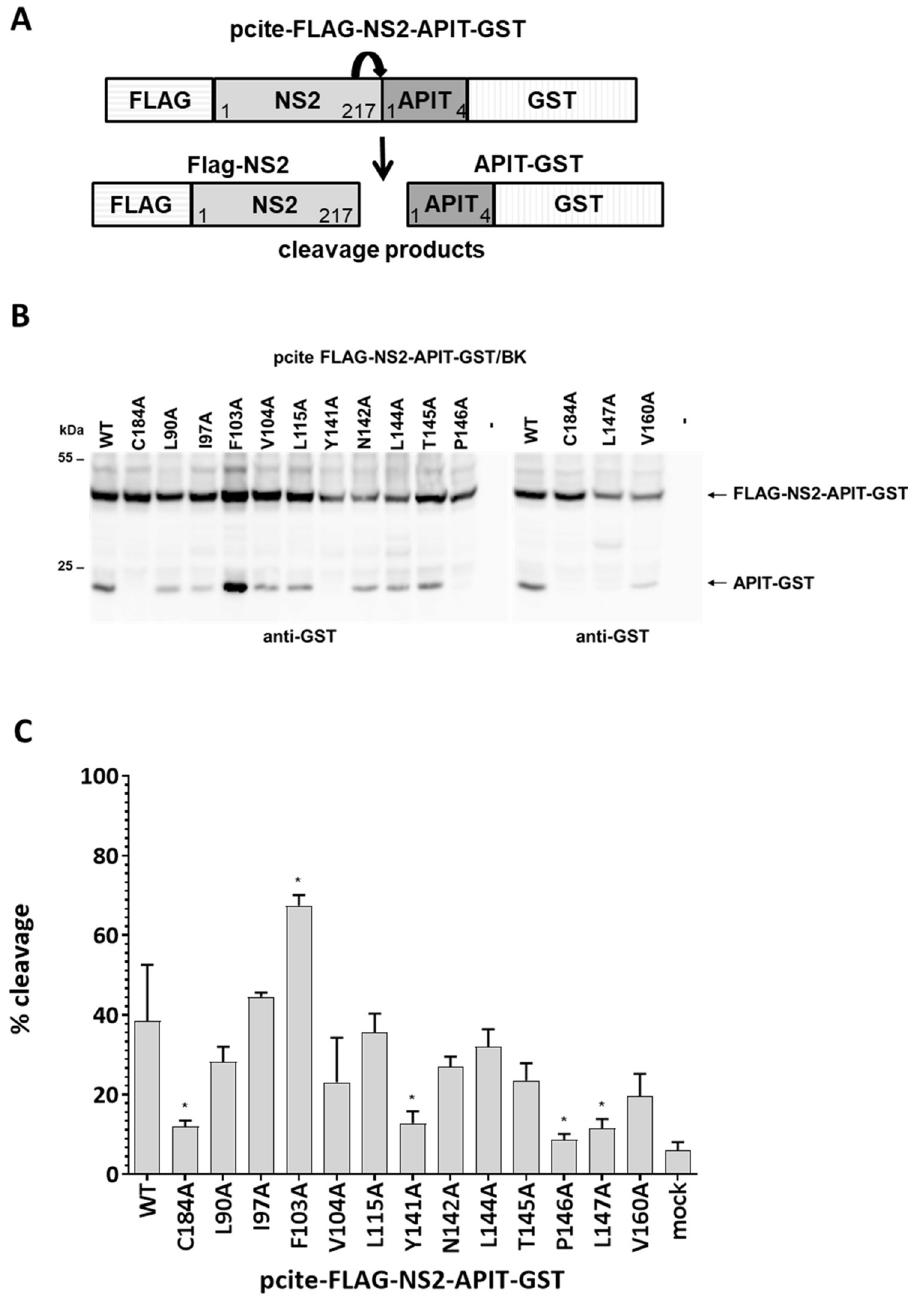
Fig 2. Re-analyzing of NS2 pro surface residues in the NS2-APIT-GST context revealed F103A as a stimulating determinant for the intrinsic NS2 pro activity in the absence of the NS3 cofactor. (A) Schematic representation of the pcite-FLAG-NS2-APIT-GST expression construct used to analyze the NS2 pro activity in the absence of its cofactor NS3. Cleavage of FLAG-NS2-APIT-GST results in generation of FLAG-NS2 and APIT-GST. (B) Indicated pcite- FLAG-NS2-APIT-GST plasmids were transfected into Huh7-T7 cells and expressed by the MVA/T7 pol expression system. One representative blot from three independent experiments is shown. Molecular mass standards are shown on the left. Positions of the FLAG-NS2-APIT-GST and the cleavage product APIT-GST are indicated on the right. WT: wild-type; mock: transfection control without DNA. ( C ) NS2 protease cleavage efficiencies. Signals of uncleaved FLAG-NS2-APIT-GST and the cleavage product APIT-GST were quantified by ImageJ software from three Western blots to calculate the percentage of FLAG-NS2-APIT-GST cleavage. Mean and standard deviations of NS2 cleavage efficiencies from three independent experiments are presented. Asterisk indicate statistically significant differences in comparison to WT ( � p < 0.05).